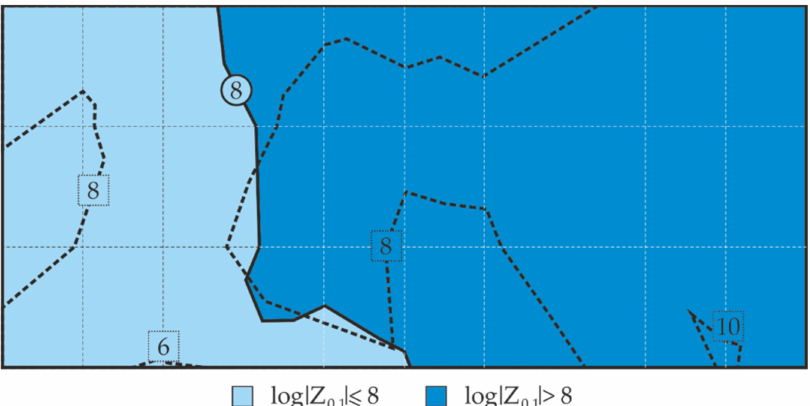
Figure 16. Map of distribution of the logarithm of impedance modulus Z 0,1 calculated from the correlation relationships given in Figure 15, based on measured thickness t of blue coating on the large steel